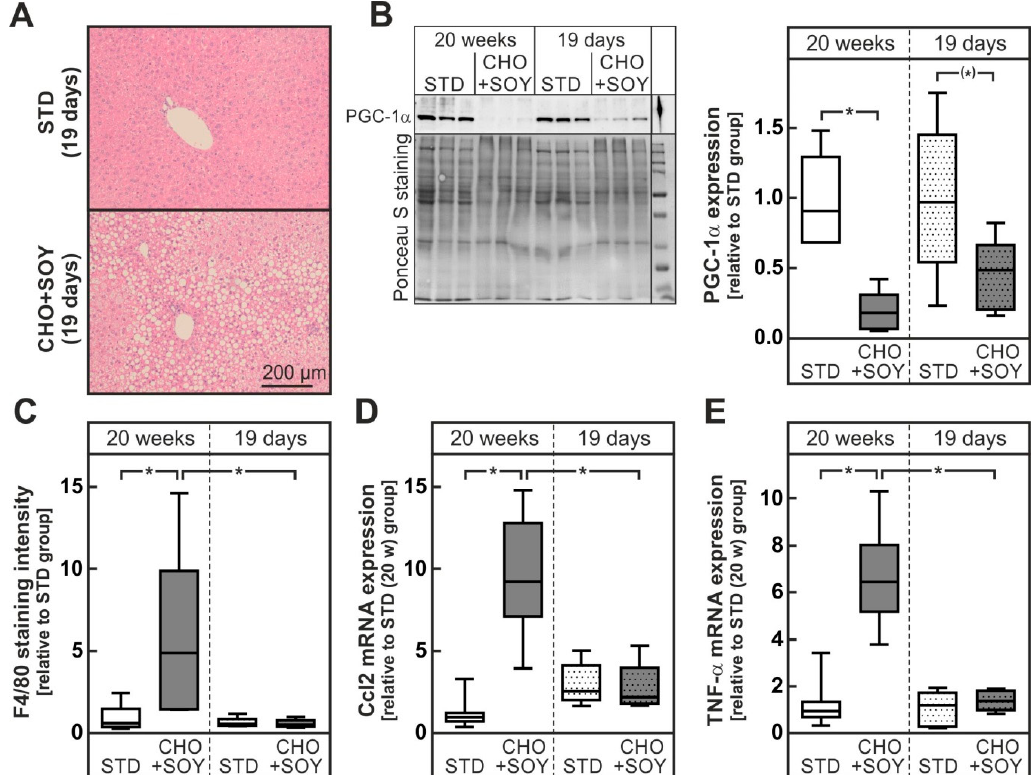
Figure 7. Enhanced mitochondrial damage but no signs of inflammation in mice fed a CHO + SOY diet for 19 days. Mice received the STD CHO + SOY diet for 20 weeks or 19 days. ( A ) Representative H&E-stained microphotographs of the liver. ( B ) Hepatic protein expression of PGC-1 α after 20 week and 19 days feeding intervention. Dense intensity was normalized to Ponceau S staining, which was verified on the same Western blot membrane as a loading control and calculated relative to the STD group in each gel. A representative blot is shown. All original blots are provided in the Supplementary Material, Figure S4. ( C ) Quantification of F4/80-stained microphotographs of the liver calculated by dense intensity of F4/80 relative to the amount of cytosolic background per field in 5 randomly chosen microphotographs per liver section. ( D , E ) Relative mRNA expression of Ccl2 ( D , alternative name Mcp-1) and tumor necrosis factor α (TNF- α , E) in mice liver. Values are median (line), upper- and lower quartile (box) and extremes (whiskers) of 6 ( B , C ) or 6–7 ( D , E ) mice per group. Statistics: One-way-ANOVA with Tukey’s post hoc test for multiple comparisons. *: p < 0.05.